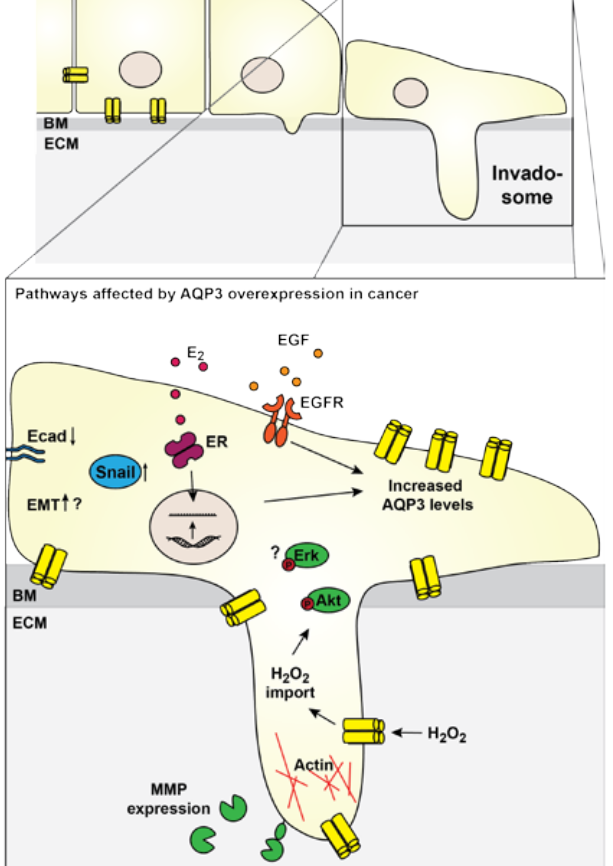
Figure 2. Schematic showing signaling affecting AQP3 overexpression and the downstream effectors. In cancer, AQP3 is often upregulated. Upregulation may be stimulated by EGF signaling. Moreover, in ER-positive breast cancer, estrogen signaling increased AQP3 transcription. Some downstream effects of AQP3 in cancer have been identified or suggested. AQP3-mediated H 2 O 2 uptake was necessary for increased protein kinase B (Akt) phosphorylation, and AQP3 may also affect extracellular signal-regulated kinase (Erk)1/2 phosphorylation through so far unknown mechanisms. AQP3 overexpression was necessary for increased expression of MMPs, which promote cancer cell invasiveness. Actin is polymerized in the leading edge of migrating cells, and AQP3 localizes here as well. AQP3 overexpression facilitated downregulation of E-cadherin and up-regulation of Snail suggesting a contribution of AQP3 to EMT. BM: Basement membrane; E 2 : Estradiol; Ecad: E-cadherin; ECM: Extra-cellular matrix; EGF: Epidermal growth factor; EGFR: Epidermal growth factor receptor; EMT: Epithelial-to-mesenchymal transition; ER: Estrogen receptor; MMP: Matrix-metallo protease.